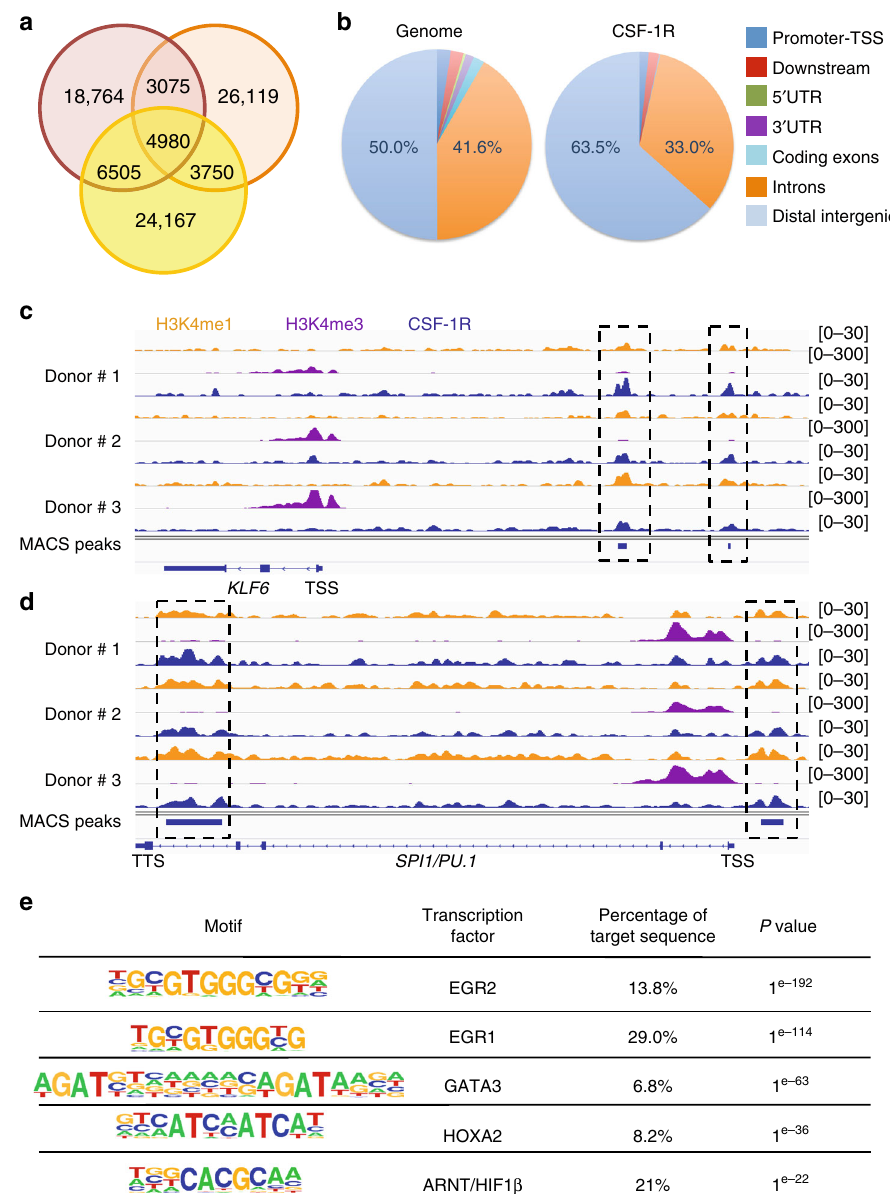
Fig. 3 CSF-1R is recruited to the chromatin in human monocyte nucleus. a Venn diagram of peak calling (input normalization) from ChIP-seq experiment with sc-46662 anti-CSF-1R antibody performed on peripheral blood monocytes collected from 3 healthy donors. b Repartition of the ChIP-seq peaks common to the 3 donors on the genome (right panel) as compared with hg19 reference genome annotation (left panel). c , d Peak calling for CSF-1R (blue), H3K4me1 (orange) and H3K4me3 (purple). ChIP-seq on KLF6 ( c ) and SPI1/PU.1 ( d ) genes in the three healthy donor monocytes (TSS: transcription starting site, TTS: transcription termination site). e Motif analysis of ChIP-seq peaks common to the 3 healthy donor monocyte recruitment site (Fig. 5c, d). Collectively, these data indicate that CSF-1R negatively regulates PU.1 gene expression in human monocytes.